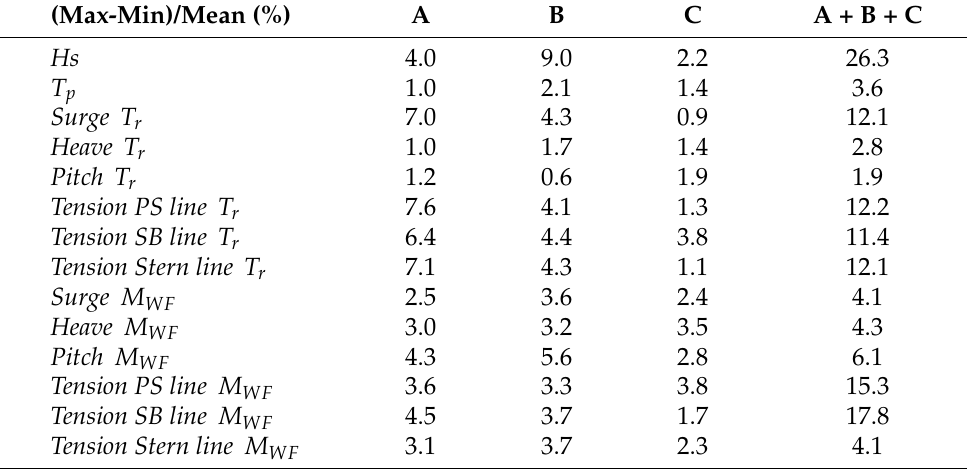
Figure 10. Metrics T r (left column) and M WF (right column) applied to surge (top row), heave (middle row), and pitch (bottom row) motions for JONSWAP T p = 1.81 s, H s = 15 cm in basins A, B, and C. The subscripts identify different seeds. Table 4. Variations (%) of wave parameters and metrics across facilities for different random seed